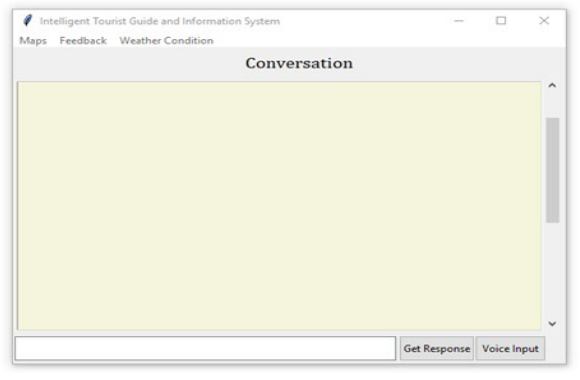
Fig. 5. Graphical user interface.